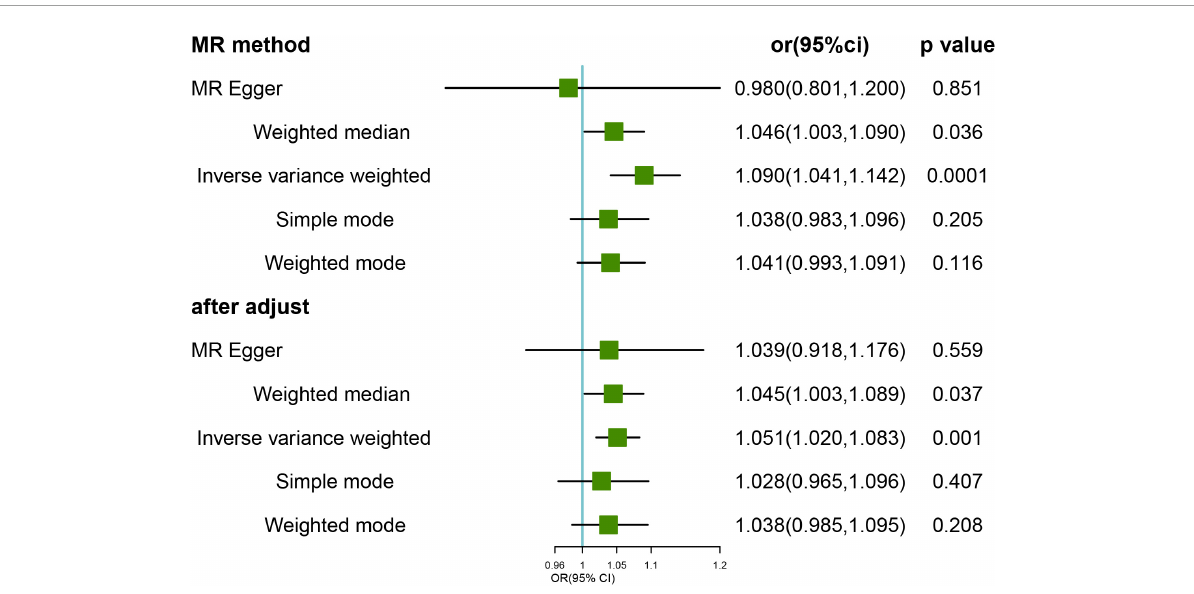
FIGURE1 Mendelian randomization (MR) results for genetically predicted frailty index (FI) and hearing loss (HL). OR, odds ratio; CI, confidence interval. After adjust: after removing the three outlier SNPs (rs1363103, rs17612102, and rs82334).